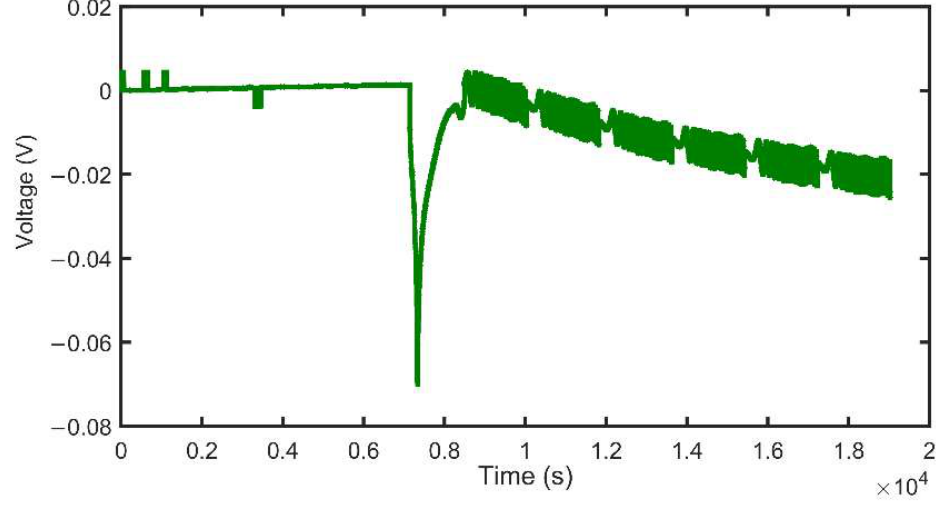
Figure 19. Voltage estimation error of test 2 under dynamic condition.